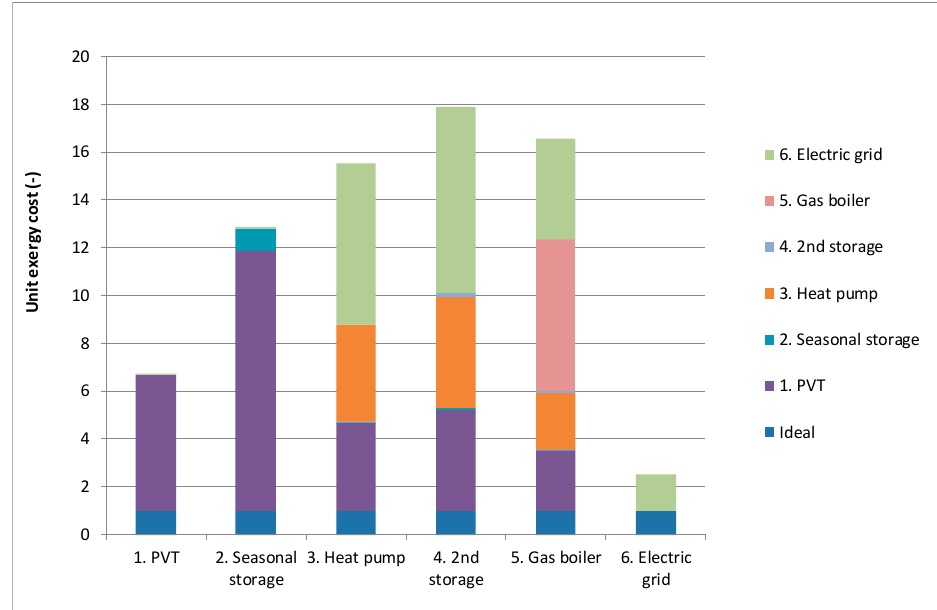
Figure 15. Cost formation by irreversibility: Year basis.